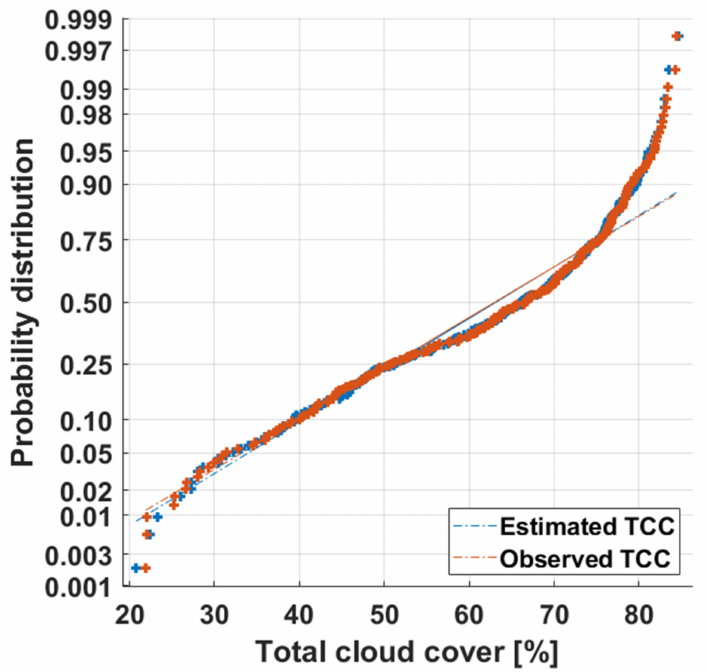
Figure 6. Comparison of probability plots for normal distribution in estimated and observed total cloud cover occurrence for all climatic zones in the study